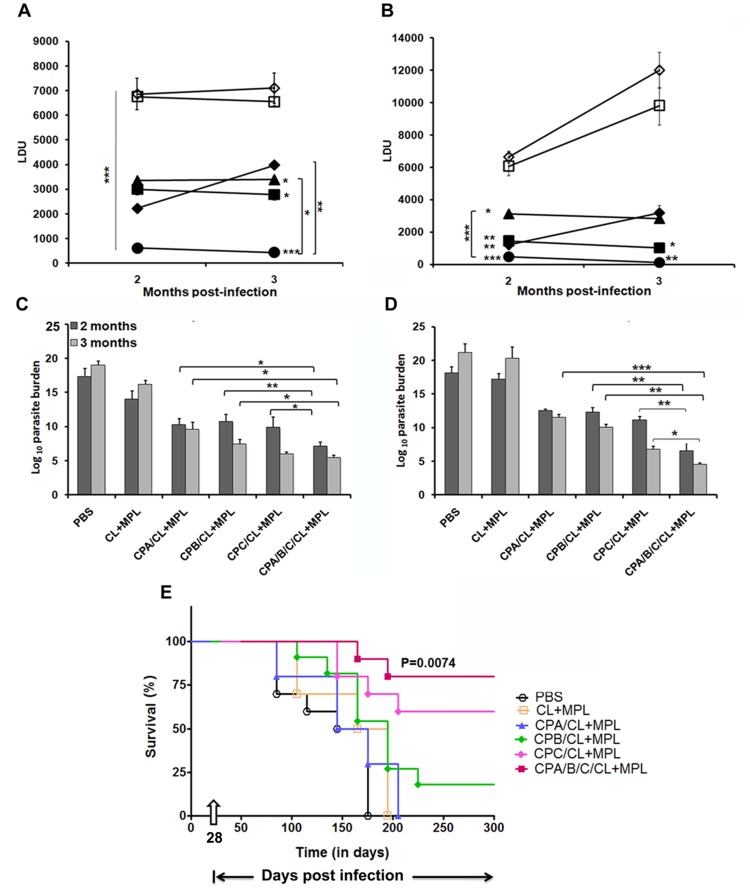
Protection and survival against L. donovani infection in immunized hamsters.A–D, kinetics of liver (A) and spleen (B) parasite burden by LDU, liver LDA (C) and spleen LDA (D) of hamsters 2 and 3 months after intracardiac challenge of 2×107 virulent L. donovani promastigotes. Results are expressed as log of total organ parasite burden. Data represent the mean ± S.E. (n = 5/group). ***p<0.001 compared to adjuvant controls. Asterisks over line indicate significant differences between groups. E, Kaplan-Meier survival curves comparing survivality in different groups of vaccinated hamsters. Survival results are from 10 hamsters per group. Survival distribution was analyzed by log-rank (Mantel-Cox) test, and level of significance is indicated by P value.